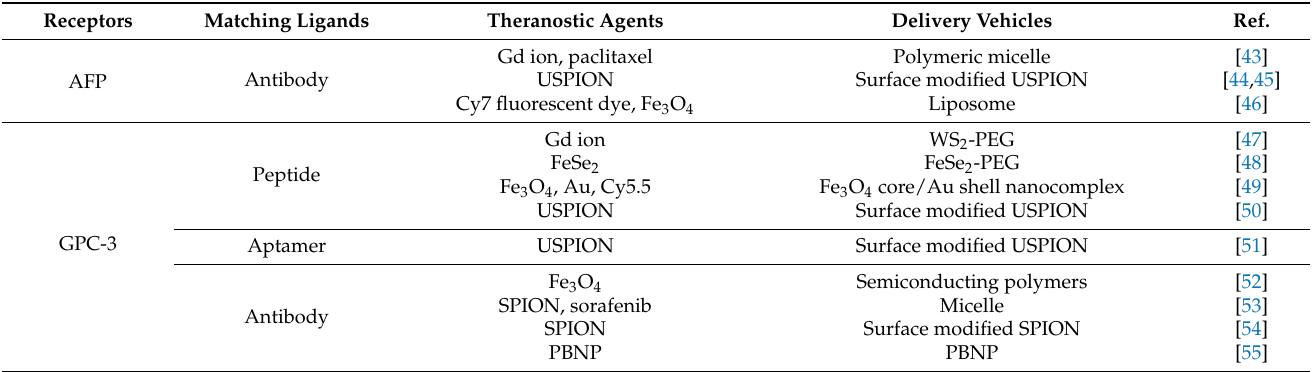
Table 2. Summary of targeted-delivery strategy based on overexpressed receptors in HCC mentioned in this